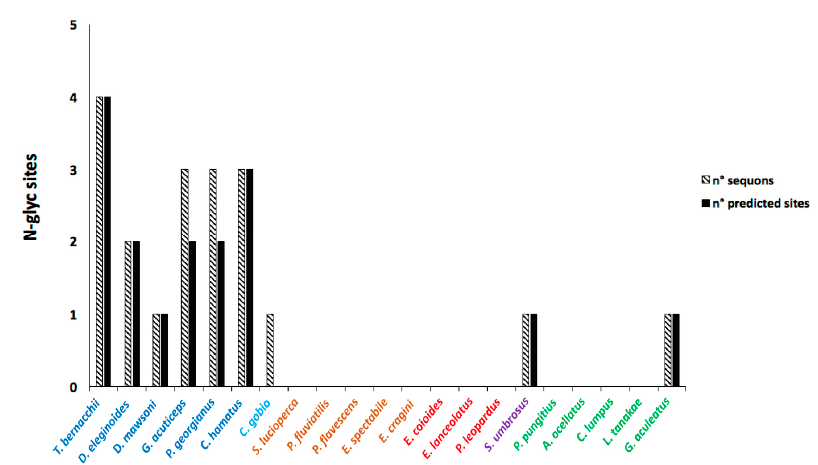
Figure 9. Distribution of potential N-glycosylation sequons (diagonal black bars) and glycosylated sequons (black bars) in the pIgR of Antarctic (blue) and non-Antarctic (light blue) notothenioid species compared to representative species of the temperate perciform suborder Percoidei (brown), Serranoidei (red), Scorpaenoidei (purple), and Cottoidei (green).